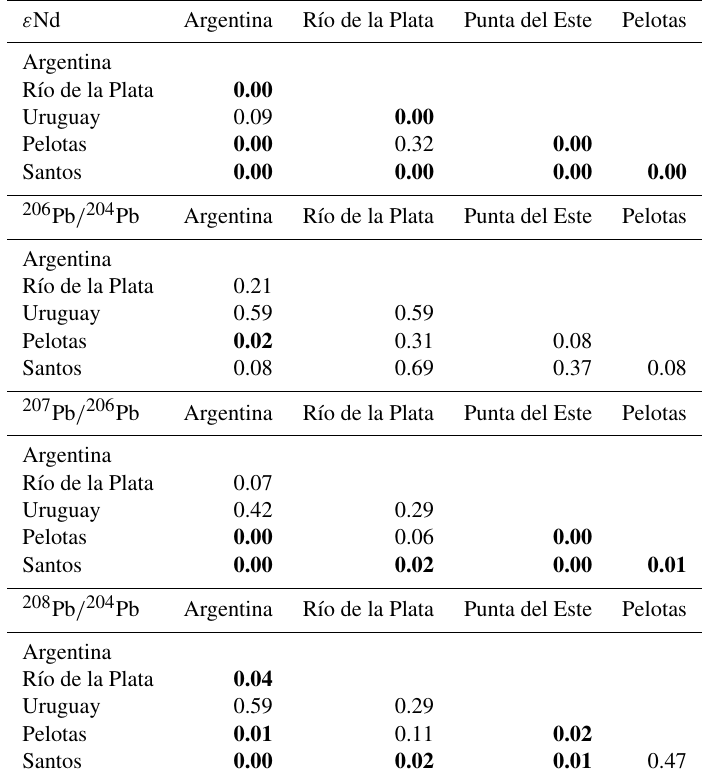
Table 1. The p values of the Mann–Whitney pairwise test. Statistically significant differences are in bold. ε Nd Punta del Este Pelotas 0.00